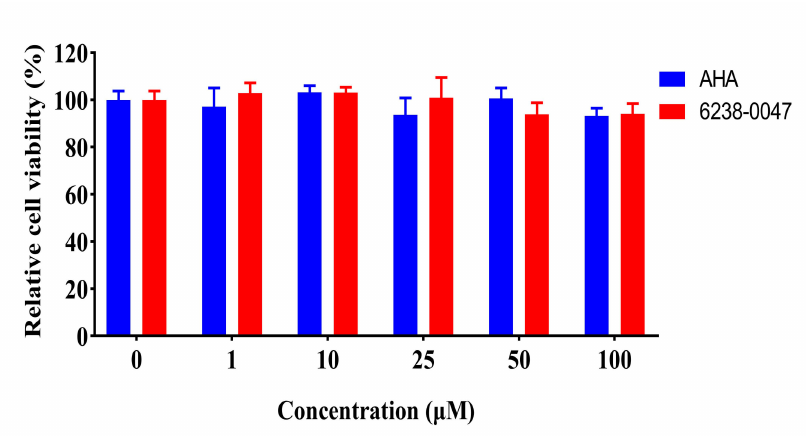
Figure 7. Influence of AHA and compound 6238-0047 on cell viability of Caco-2 cell culture. The results were presented as the mean ±